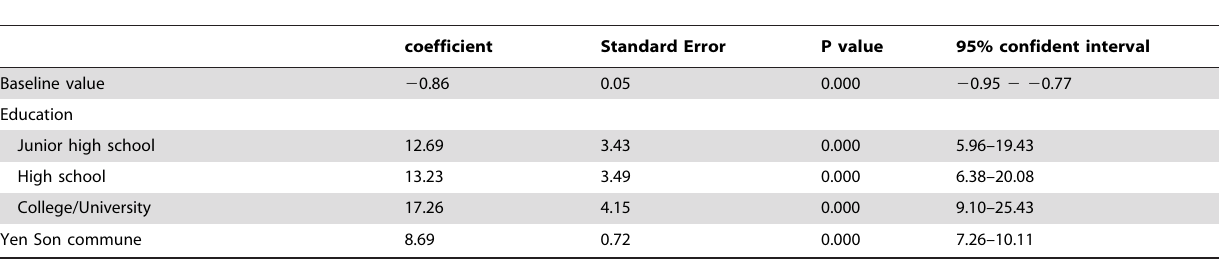
Table 5. Results of multivariate analysis of the attitude-practice